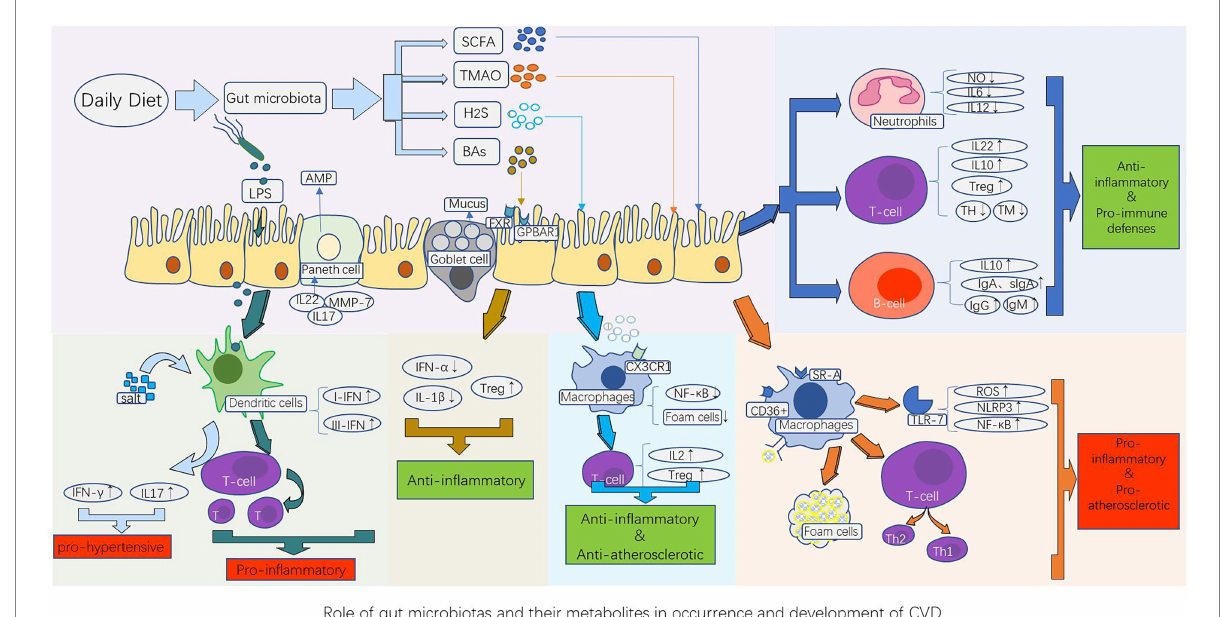
FIGURE 1 Role of gut microbiota and their metabolites in the occurrence and development of CVD. The gut microbiota component LPS, as well as their metabolites such as short-chain fatty acids (SCFAs), trimethylamine N-oxide (TMAO), bile acids (BAs), and hydrogen sulfide (H2S), stimulate the innate immune system (dendritic cells, macrophages, and neutrophils) and adaptive immune system (B cells and T cells), thereby causing the corresponding immune response of the host cardiovascular system. This produces a series of pathological changes by promoting or inhibiting the release of cytokines and inflammatory factors, such as atherosclerotic plaque formation, vasomotor dysfunction, and cardiomyocyte ischemia and necrosis, which influence the occurrence and development of CVDs. AMP, antimicrobial peptides; BAs, bile acids; FXR, farnesoid receptor; GPBAR1, G protein-coupled bile acid receptor 1; H2S, hydrogen sulfide; IFN- γ , interferon- γ ; IL-10, anti-inflammatory factors; LPS, lipopolysaccharides; MMP-7, Matrix metalloproteinase-7; NF- κ B, nuclear factor kappa B; NLRP3, nucleotide-binding and oligomerization domain- like receptor protein 3; ROS, reactive oxygen species; SCFAs, short-chain fatty acids; SR-A, type A scavenger receptor; TMAO, Trimethylamine N-oxide; Treg, regulatory T cells; TLR-7, Toll-like receptor-7; TH, T helper cell; TM, T memory